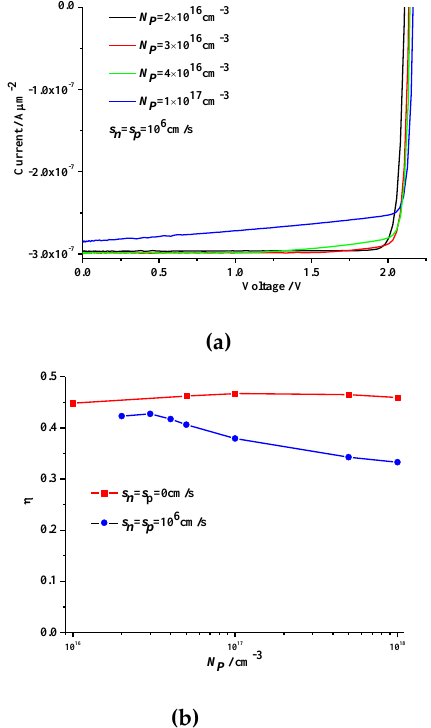
Figure 7. Output characteristics ( a ) and conversion efficiency ( b ) of the battery with different N P.